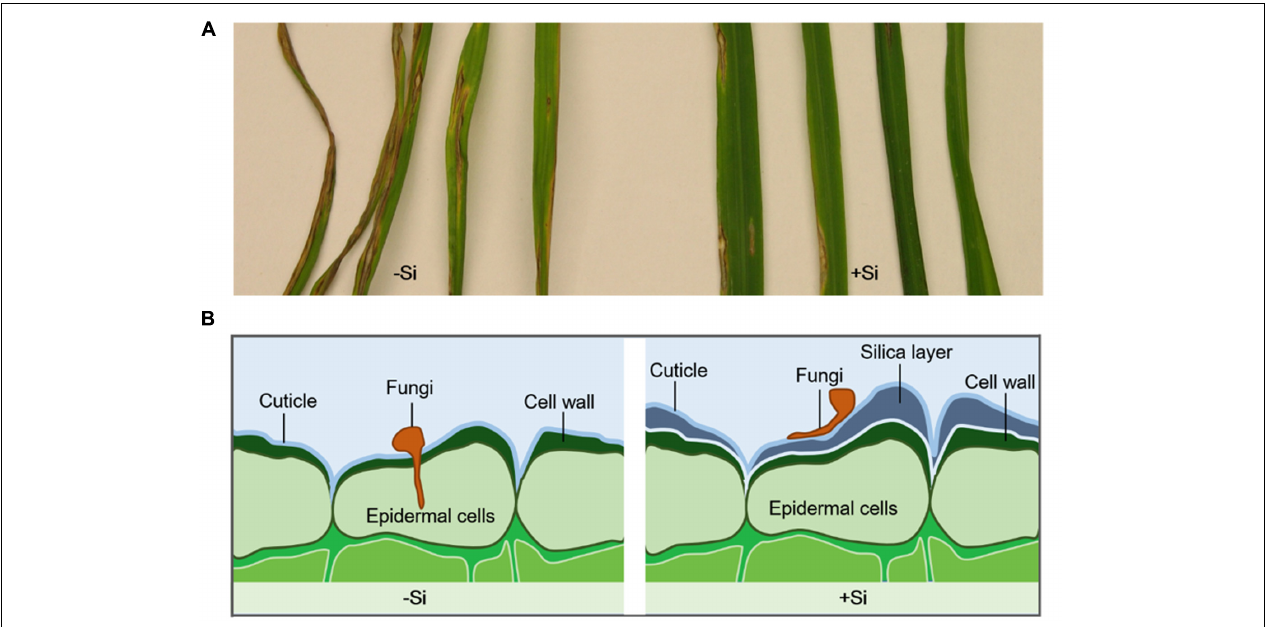
FIGURE 1 | (A) Leaf blast symptoms in rice after inoculated with Magnaporthe grisea for 10 days (Sun et al., 2010). Rice plants were continuously treated with (+Si) or without silicon (–Si). (B) Silica layer was formed in the cell wall of Si-treated plants and enhanced plant resistance to fungi infection by physical